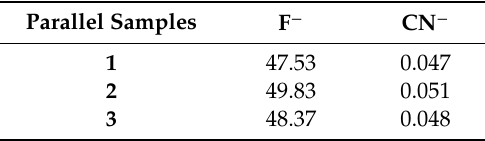
Table 4. Leaching toxicity of the SPL-1cut final product treated with dolomite (mg · L − 1